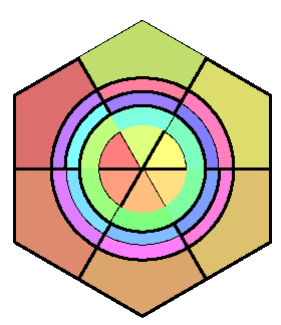
Figure 1. FSRs division of a fuel pin.